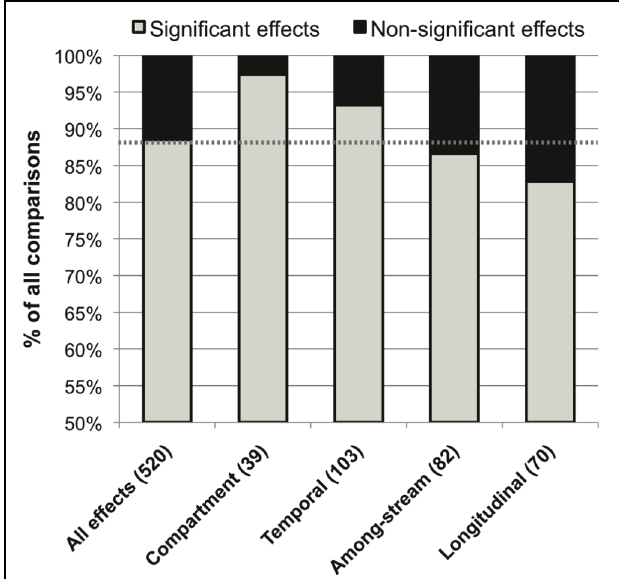
FIGURE 3 | Distribution of significant (in gray) and non-significant (in black) reported effects of categories of spatiotemporal variation on stream microbial diversity, with number of included studies noted for each category along the x-axis, and the percentage of significant effects for all comparisons combined noted as a dashed line for